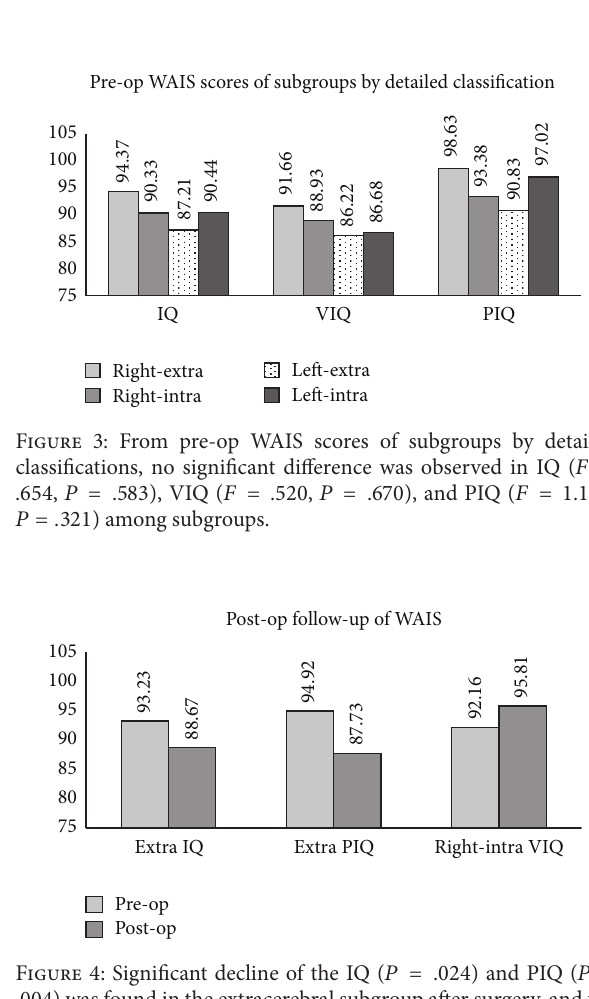
Figure 2: Preoperative IQ, VIQ, and PIQ of both left and right hemisphere subgroups were lower than those of the healthy controls ( 𝑃 < .05 ). No significant difference was found between the two tumor subgroups.